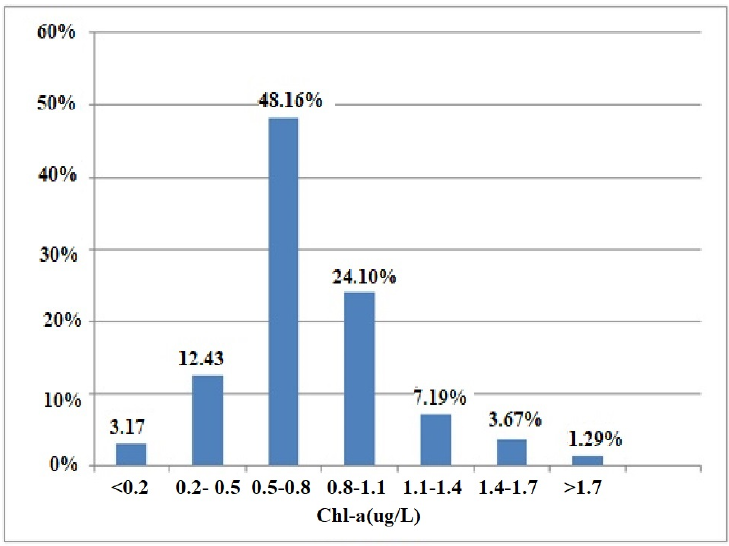
Figure 26. Chl-a concentration proportion distribution in SYB.